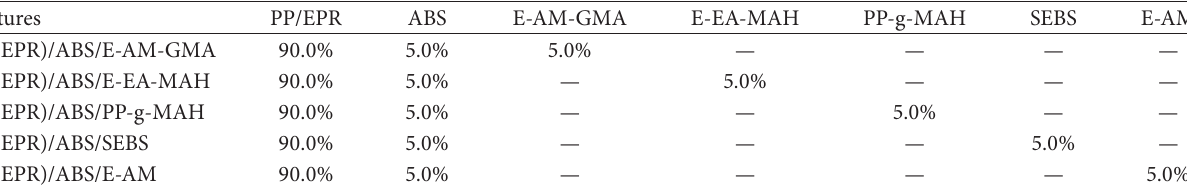
Table 5: Composition of blends (PP/EPR)/ABS/compatibilizer at a rate of 5% of one of the five compatibilizers.